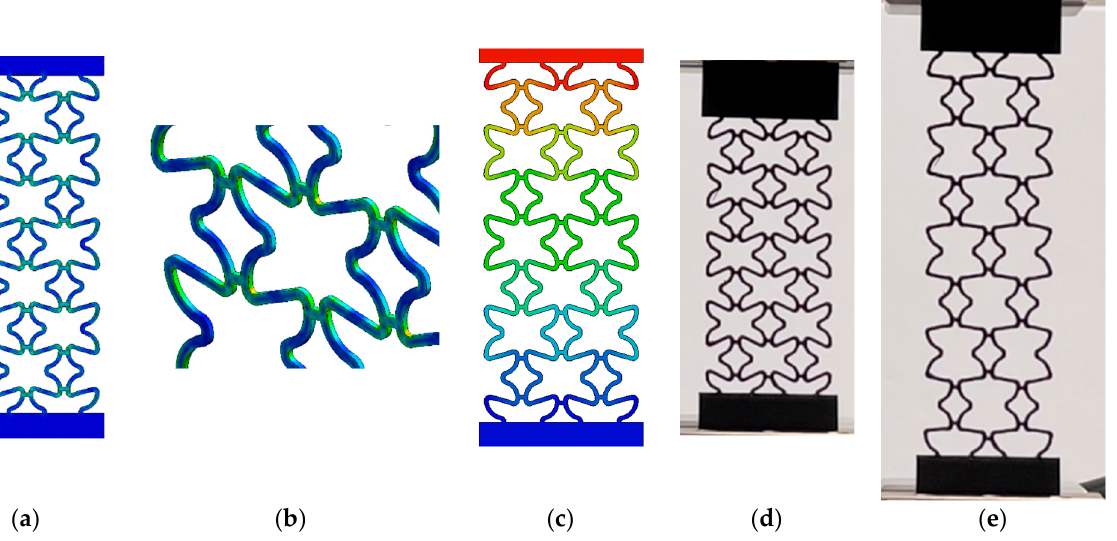
Figure 6. RCSS structure with FEA, unstretched length, and stretched length: ( a ) FEA stress analysis, ( b ) FEA close-up for stress concentration, ( c ) FEA displacement, ( d ) printed structure, ( e ) stretched printed structure.